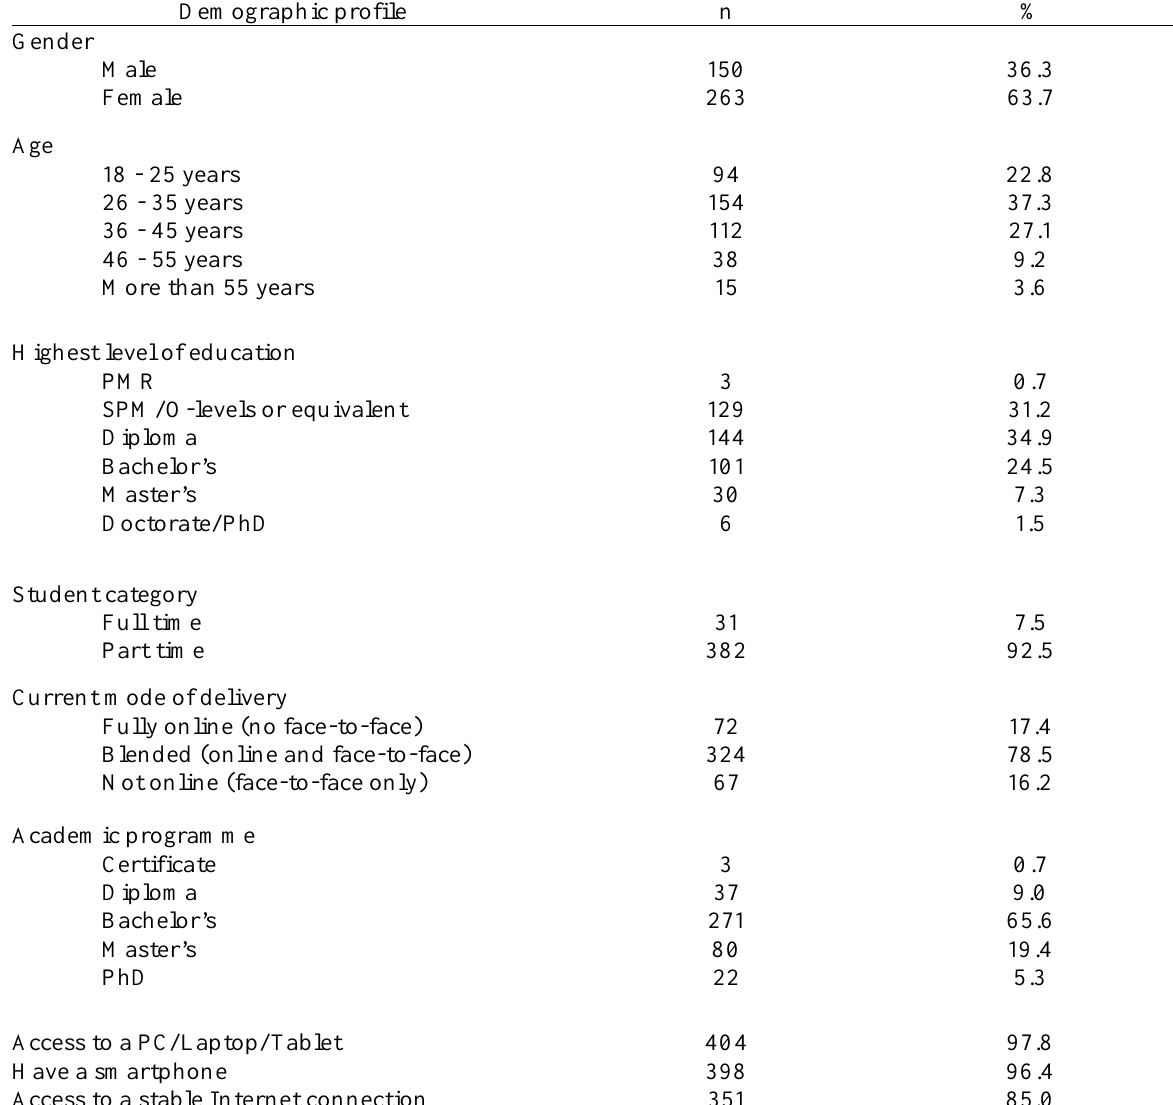
Demographic Profile of Adult Students Demographic